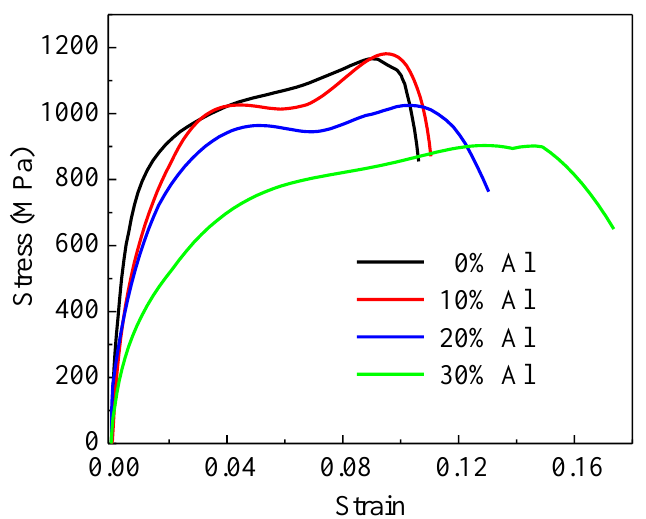
Figure 5. The simulated dynamic stress-strain curves of Ti–Al3Ti–Al laminated composites with different Al contents.